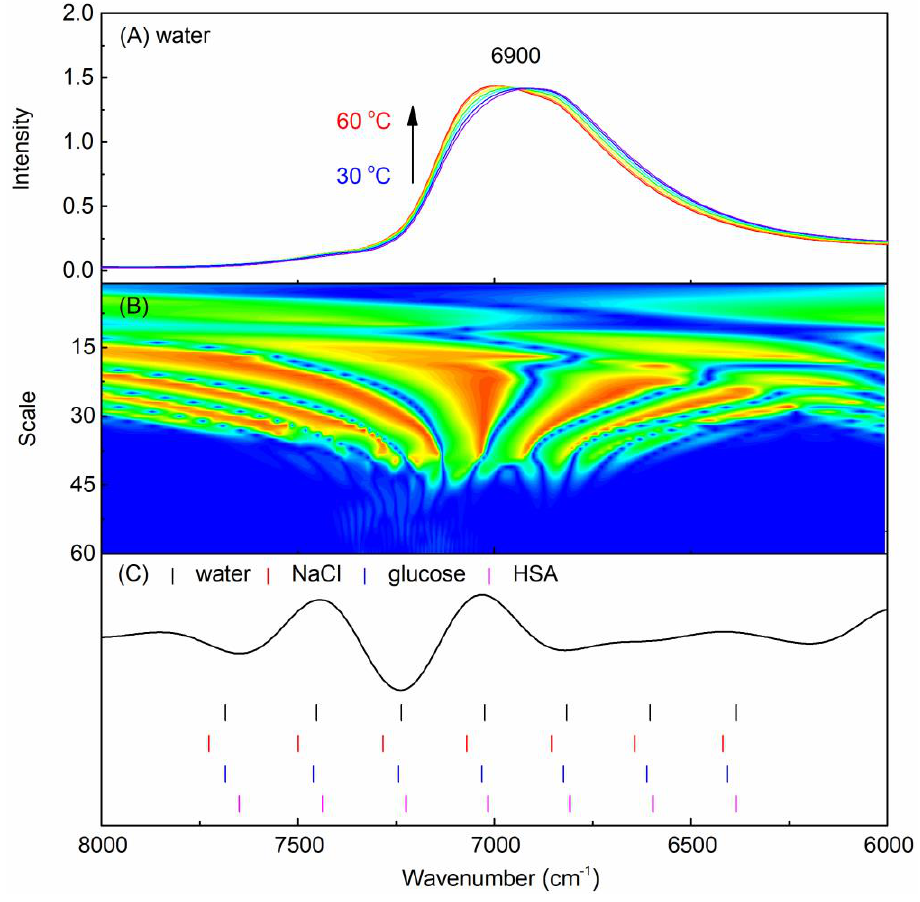
Figure 5. NIR spectra of water at different temperature ( A ), CWT spectra at different scales ( B ), and the temperature-dependent variables in the spectrum of water, NaCl, glucose, and HSA solutions ( C